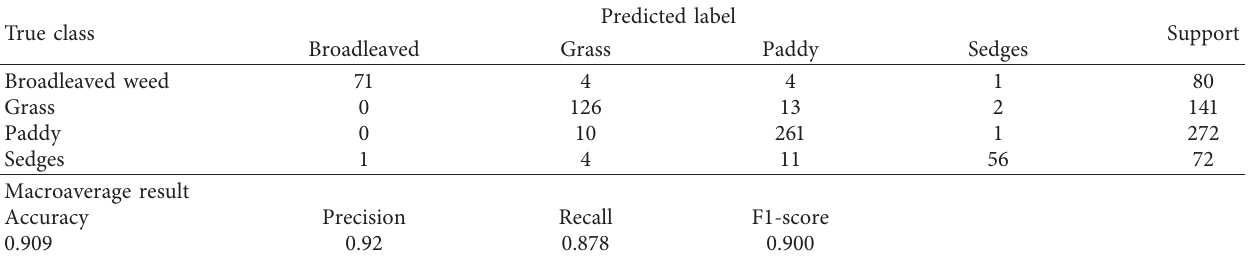
Table 7: Classification result of MCS-2.